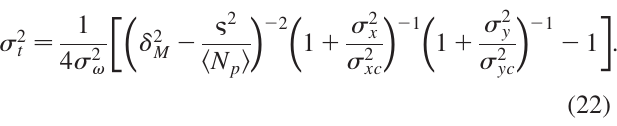
FIG. 3. (Color) Examples of fluctuation and streak camera bunch length measurements at the ALS for different beam